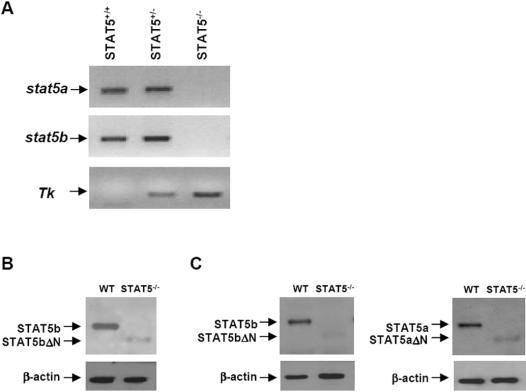
Characterization of wild-type and STAT5−/− C57Bl/6 mice.(A) Tail DNA from STAT5+/+, STAT5+/−, and STAT5−/− C57Bl/6 mice was prepared and PCR were performed to amplify wild-type stat5a and stat5b DNA as well as the TK cassette. The primers are given in the Material and methods section. (B) LSECs were isolated from wild-type (WT) and STAT5−/− mice. Whole-cell extracts were prepared and analyzed for STAT5b and STAT5bΔN expression by immunoblot. We used an antibody (G-2) directed to an epitope mapping at the C-terminus of STAT5b. Equal loading of proteins on the gel was confirmed by probing the blots for β-actin. (C) Blood neutrophils were isolated from WT and STAT5−/− mice. Whole-cell extracts were prepared and analyzed for STAT5b/STAT5bΔN (left panel) and STAT5a/STAT5aΔN (right panel) expression by immunoblot. For STAT5b/STAT5bΔN, we used the G-2 antibody. For STAT5a/STAT5aΔN, we used an antibody (L-20) raised against a peptide mapping at the C-terminus of STAT5a. Equal loading of proteins on the gel was confirmed by probing the blots for β-actin.